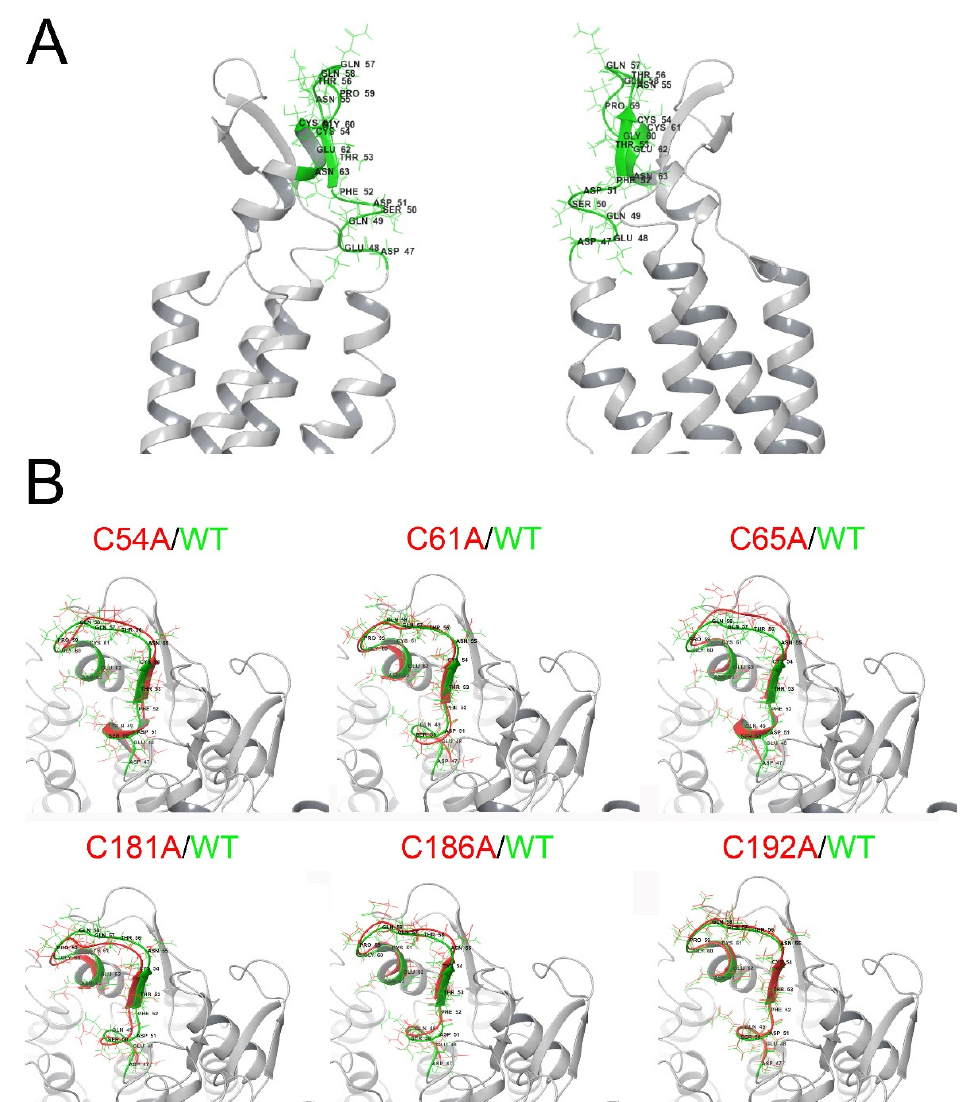
Figure 6. MD simulations suggest changes in the 3D disposition of the TM1-EL1 parahelix segment. Human Cx46 50-ns MD models. ( A ) Representation of a Cx46 hemichannel showing the location of the parahelix (green segment). ( B ) Zoom of the parahelix segment (the segment between amino acids 47 and 61 was analyzed). The configuration of this segment in the wild-type Cx46 (green) is superimposed on the parahelix model for each Cys mutant (red).